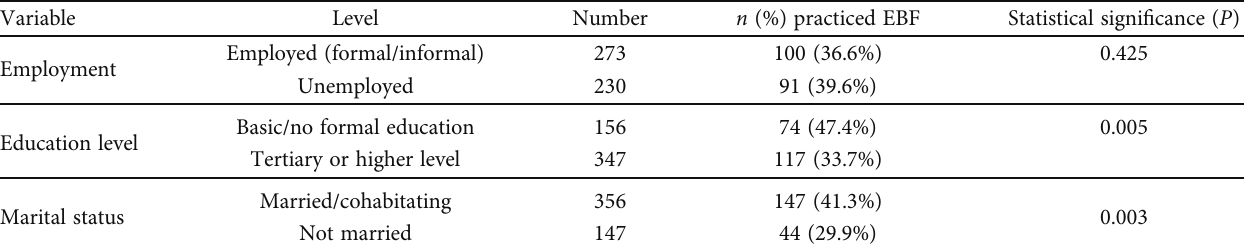
Table 3: Characteristics of factors that a ff ected the duration of EBF.